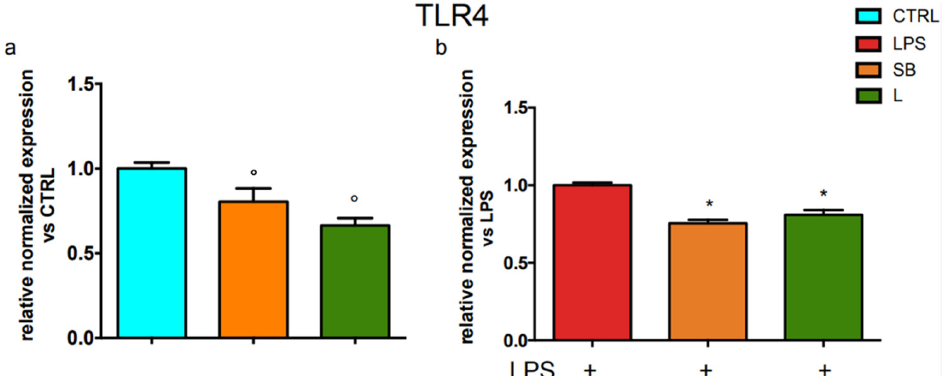
Figure 3. RT-PCR analysis of TLR4 gene expression in BV-2 cells treated with chestnut extracts. BV-2 cells were treated with spiny bur or leaf extracts (0.5 mg/mL) for 3 h, then stimulated (or not) with LPS (0.5 µ g/mL) for a total of 24 h. At the end of incubation, RNA was extracted from cells and samples were subjected to RT-PCR analysis using a specific primer for TLR4, as explained in the Materials and Methods section. The relative mRNA content of TLR4 was normalised to ( a ) untreated control and ( b ) untreated LPS control. Relative quantification is obtained as reported in the Materials and Methods section; results are expressed as means ± SEM of three independent experiments. Statistical analysis was performed by Fisher’s LSD test following one-way ANOVA. ◦ p < 0.05 significantly different from control cells; * p < 0.05 significantly different from LPS-treated